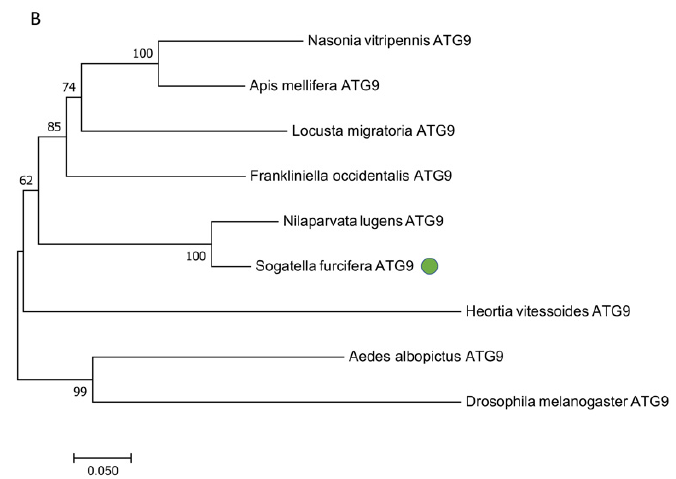
Figure 2. Phylogenetic analysis of ATG3 ( A ) and ATG9 ( B ). Multiple alignments of amino acids of ATG3 and ATG9 were performed by muscle program and the phylogenetic tree was constructed using the neighbor-joining method with a P-distance of MEGA 7.0 (5000 repetitions), respectively. 3.2. Temporal Expression of Virus Gene and Autophagy-Related Genes in SRBSDV-Exposed WBPH Females